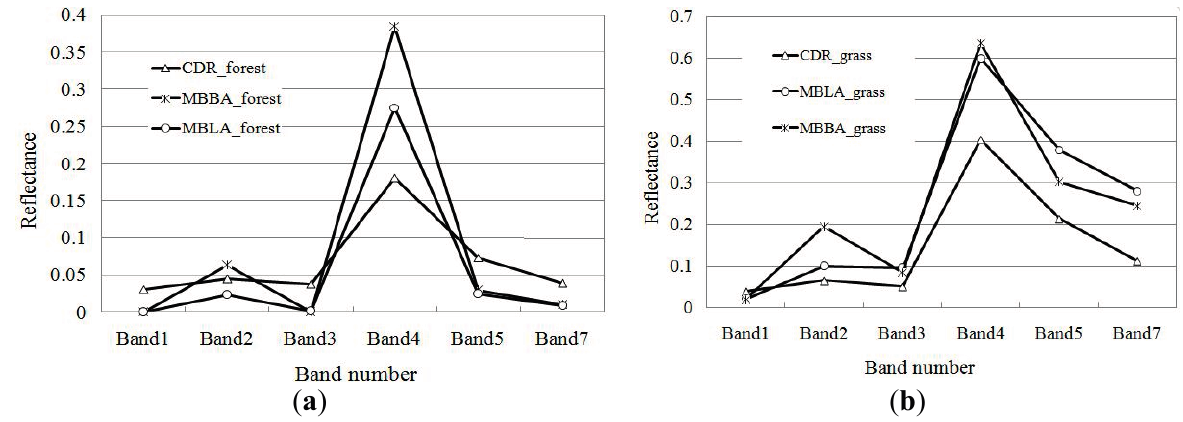
Figure 8. The spectra of the MBBA compared with the MBLA and Landsat CDR: ( a ) forest pixel (northwest-facing slope); and ( b ) grass pixel (southwest-facing